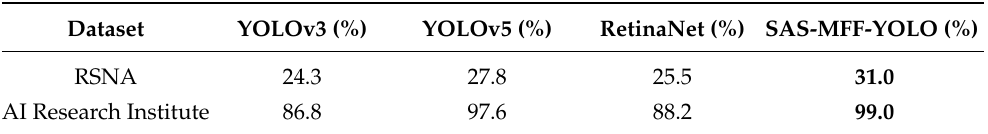
Table 4. The performance of different models in pneumonia-related lesion detection on the RSNA and the AI Research Institute datasets. The evaluation metric shown is the AP 50